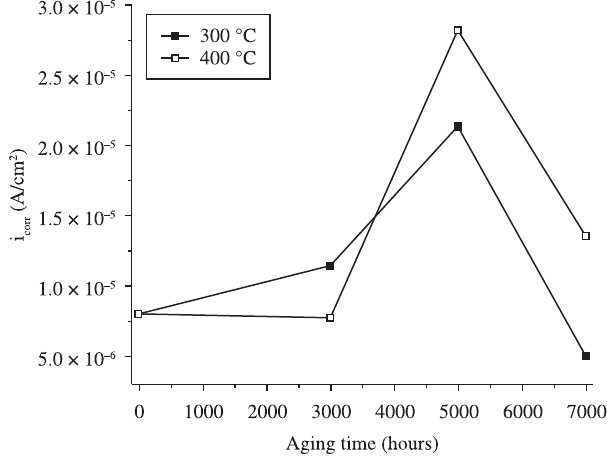
Figure 1. Effect of aging time and temperature on the corrosion current density, i , of 22.5 wt. (%) Cr duplex stainless steel alloy in a 0.1 M H corr solution at room